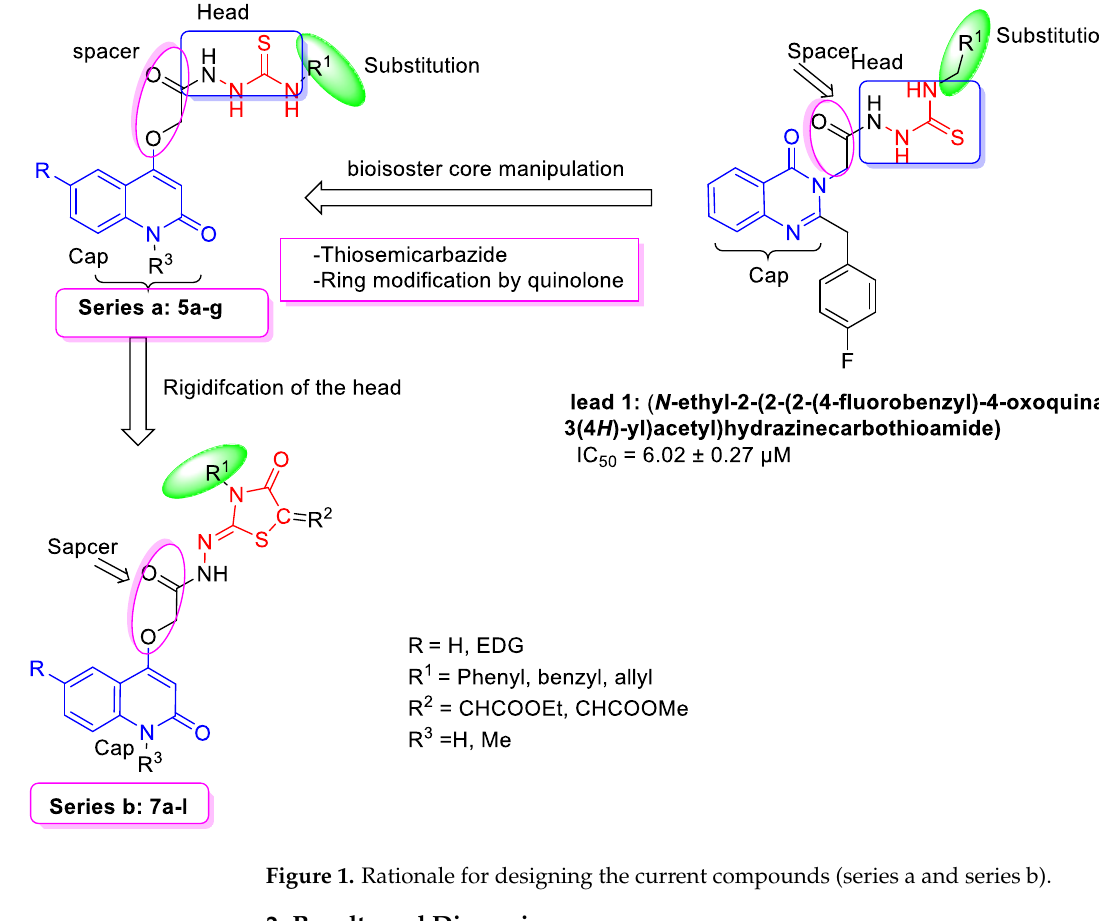
Figure 1. Rationale for designing the current compounds (series a and series b).